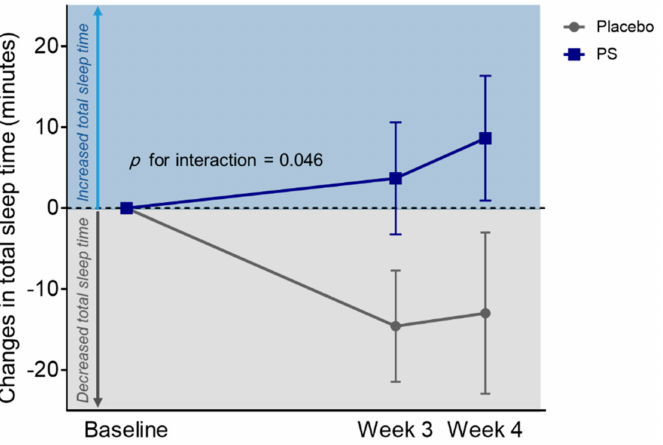
Figure 3. Changes in total sleep time between the PS and placebo group. Over the